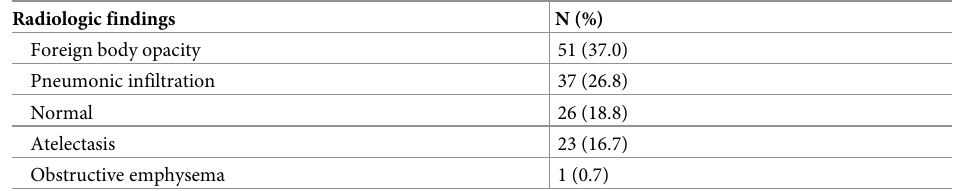
Table 2. Radiographic findings in patients with tracheobronchial foreign bodies.